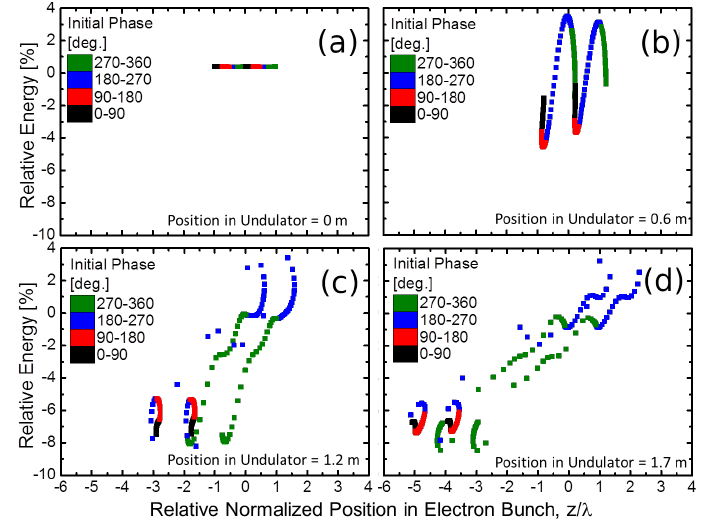
Figure 7. Simulation results for KU-FEL. Evolution of the energy of electrons with different initial phases in the undulator at the end of the macropulse is plotted: ( a – d ) phase space plots of the two-wavelength slices of the electron beam at the center of the electron bunch and at the different longitudinal positions in undulator. The longitudinal position in the undulator for ( a – d ) are 0, 0.6, 1.2, and 1.7 m, respectively. The horizontal axis is relative position in the electron bunch normalized by the lasing wavelength λ = 11.6 µ m